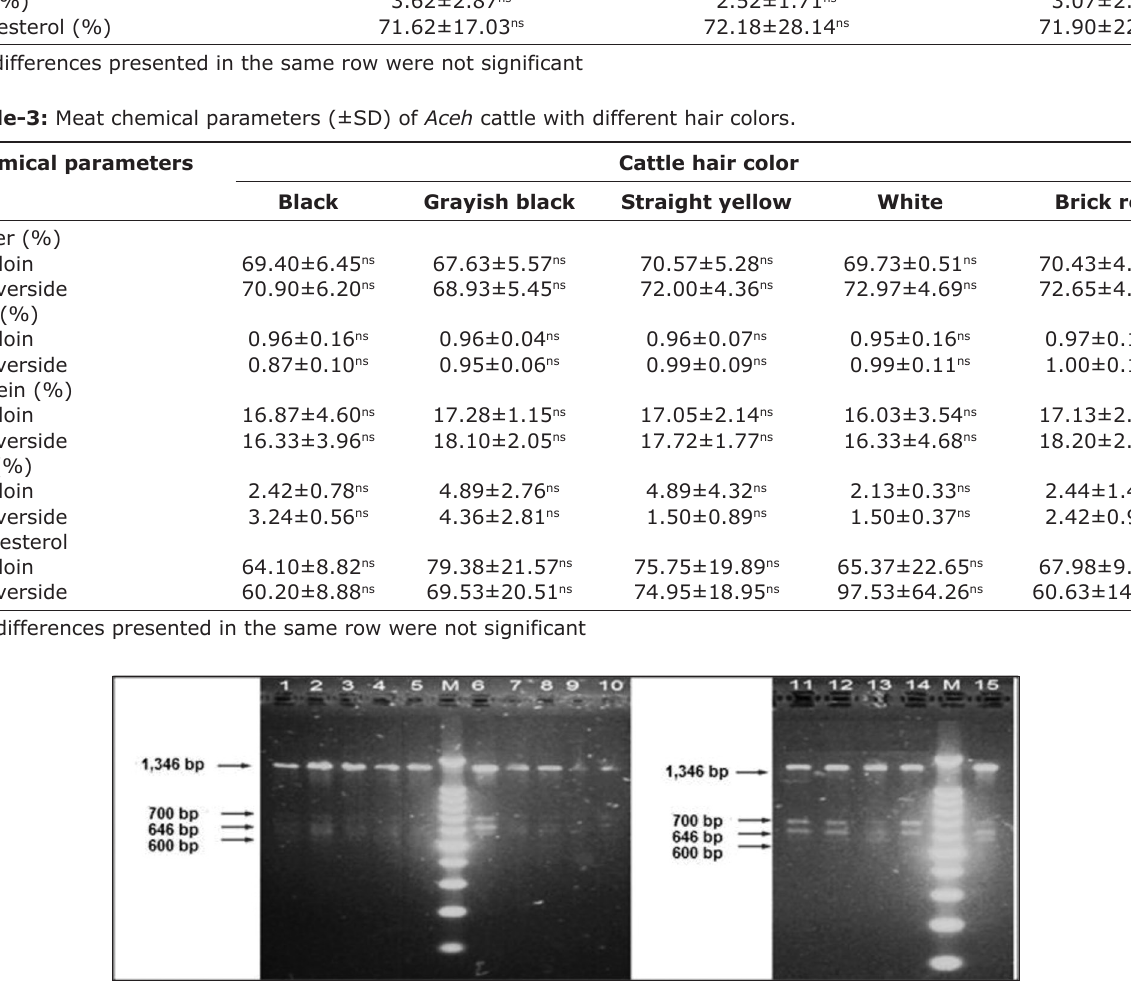
Figure-1: Results of agarose gel electrophoresis of myostatin reaction restriction fragment length polymorphism fragments (1346, 700, 646, and 600 bp). Lane M, 100 bp ladder. Lane 01-05, Aceh cattle examined